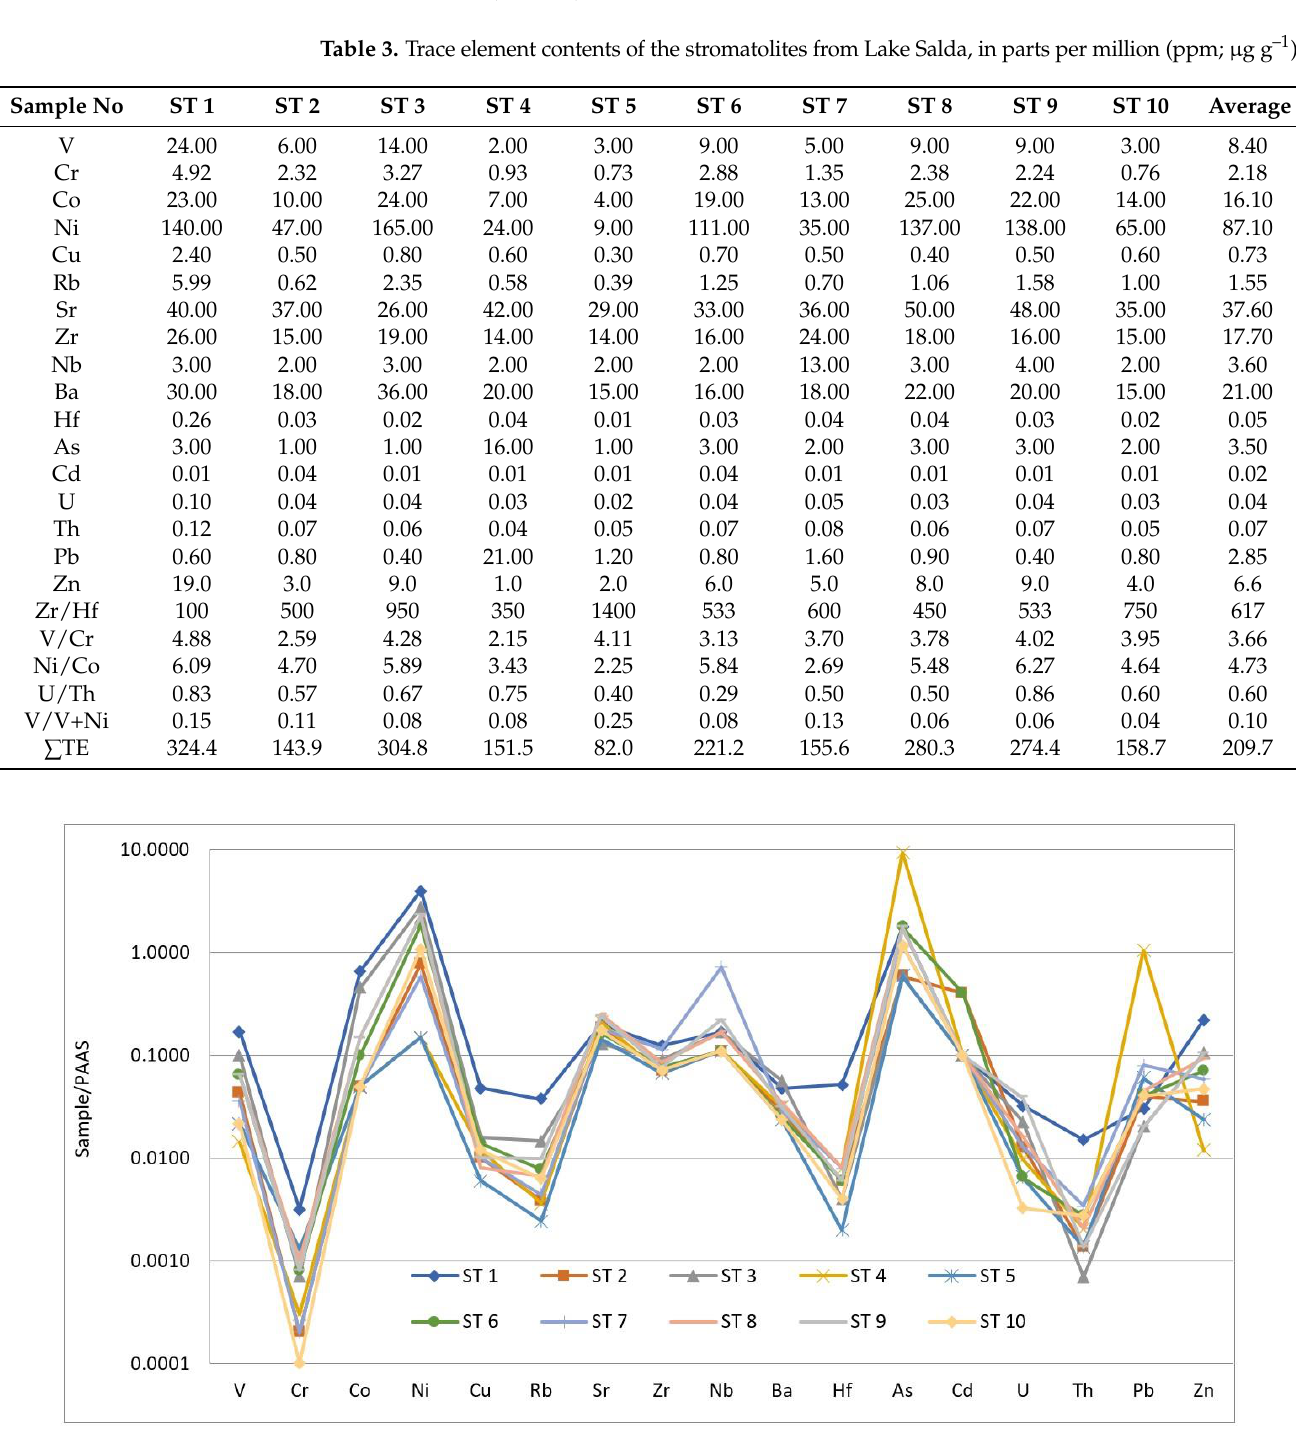
Figure 7. PAAS-normalized [52] trace element distribution of Lake Salda stromatolites.